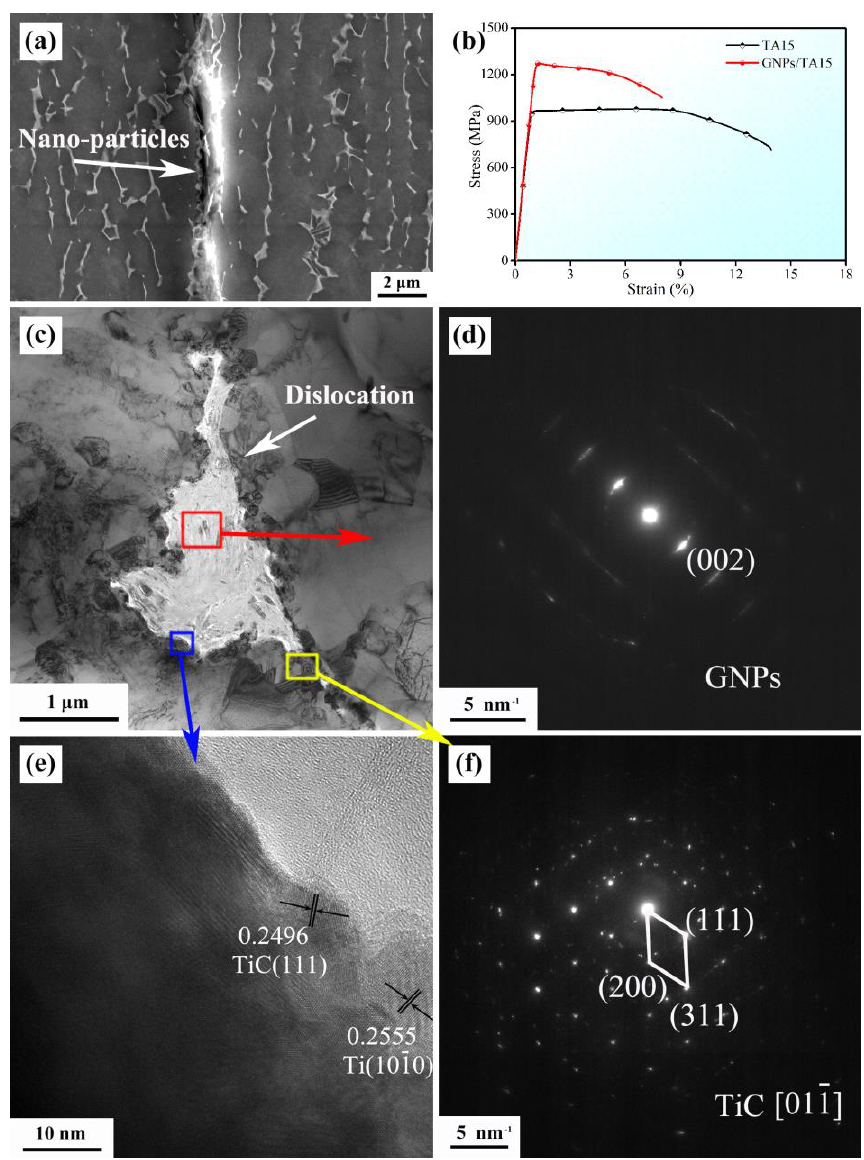
Figure 1. The SEM image along ED ( a ), room temperature stress-strain curve ( b ), TEM image along TD ( c ), selected area electron diffraction patterns ( d , f ), HR−TEM image ( e ). TD ( c ), selected area electron diffraction patterns ( d , f ), HR − TEM image ( e